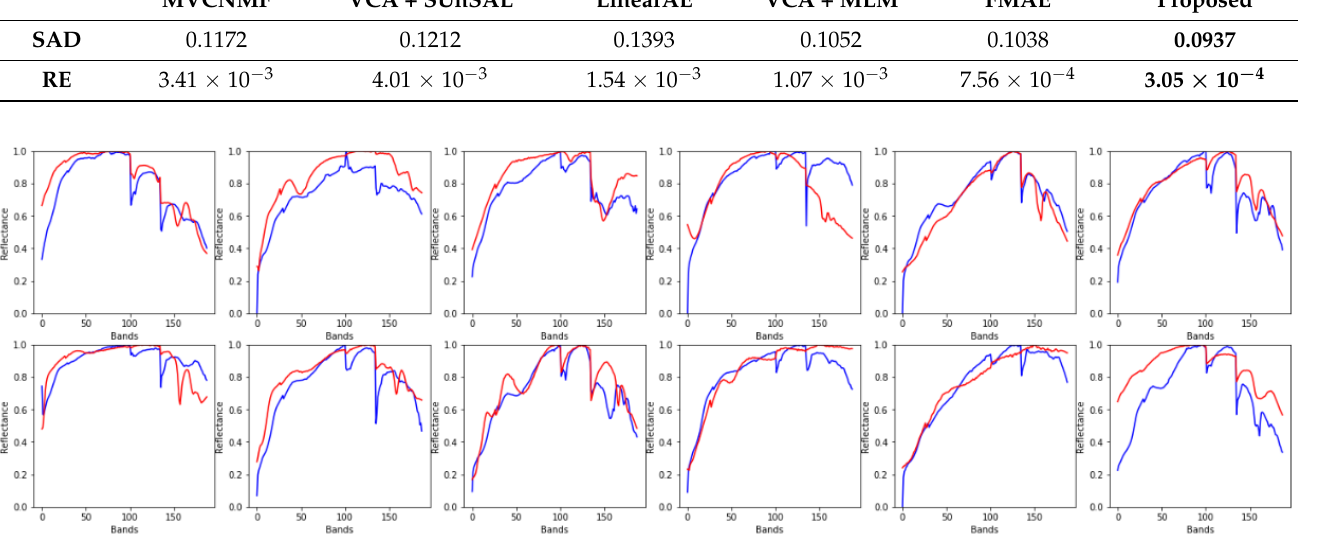
Figure 15. Comparison of the reference endmember (red line) with the endmember extracted by GBM_AE (blue line) on cuprite. From left to right on the first row: alunite, andradite, buddingtonite, dumortierite, kaolinite1, kaolinite2; from left to right on the second row: muscovite, montmorillonite, nontronite, pyrope, sphene, and chalcedony.